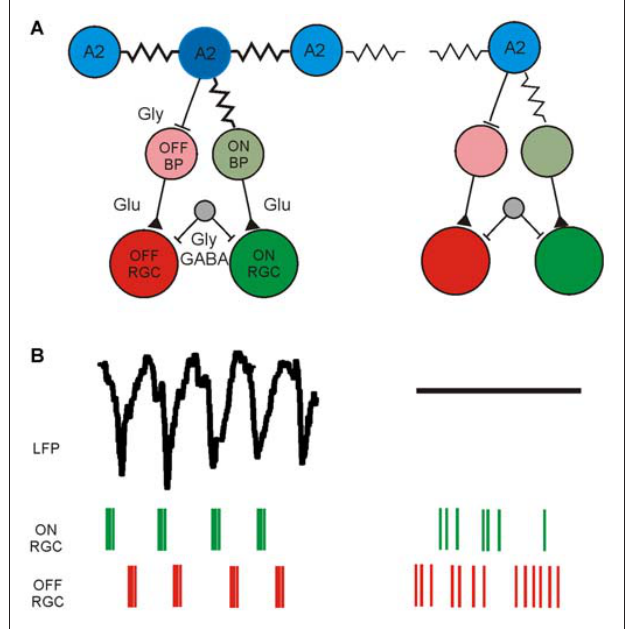
FIGURE 2 | Schematic diagram of synaptically connected retinal neurons generating rhythmic activity in the GCL of photoreceptor-degenerated retinas in the low and high frequency range. (A) Simplified schematic synaptic connectivity in rd retinas. The rhythmic activity is generated and spreads in the electrically coupled network of AII amacrine cells and ON cone-bipolar cells (ON CB) and propagates through glutamatergic excitation to ON-type RGCs. Through glycinergic inhibition the rhythmic activity reaches OFF RGCs. An unidentified cell (gray) modulates the rhythmic spiking through GABAergic and/or glycinergic input. The rhythmic activity does not occur over the entire retina, symbolized in the weakly coupled network on the right. Part of the figure modified from (Margolis et al., 2014). (B) Low-frequency LFP and rhythmic, high-frequency spiking in two different retinal ganglion cell types (ON RGC and OFF RGC) driven by the rhythmic presynaptic network. Rhythmic LFPs and RGC spiking is probably recorded only across strongly coupled areas of the RGC layer, whereas in weakly coupled regions the LFP size decreases and the spiking becomes